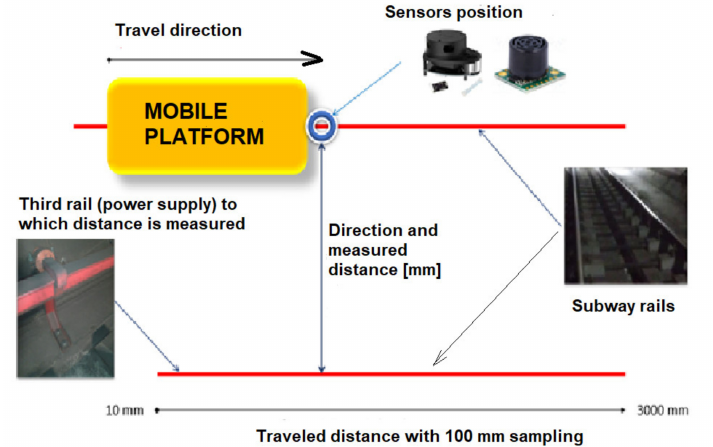
Figure 7. Test bed setup, placement of sensors and elements